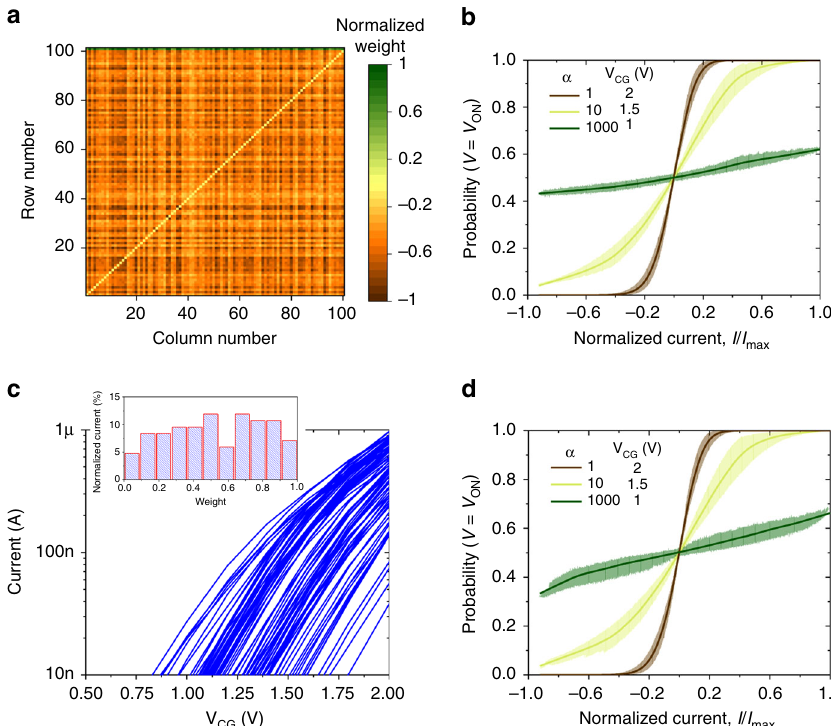
Fig. 4 Non-idealities in fl ash-memory-based stochastic dot-product circuits. a The considered distribution of neural network weights, normalized separately to its maximum value for positive (array) and negative (bias) weights. The bias weights are shown at the very top of the array. b Smearing of the stochastic neuron function due to input-dependent output-referred current noise in differential circuits for three computing temperatures. The thicker lines show the simulated values obtained by applying 10k randomly chosen inputs (neuron states) across all neurons, while solid lines show their averages. c Measured subthreshold slope I – V s for 100 memory cells. The inset shows the histogram of corresponding normalized synaptic weights, de fi ned as I cell ( V CG = 2.0V)/( I cell ) max , when using ( I cell ) max = 973 nA. d Simulated smearing of the stochastic neuron function due to the combined effect of subthreshold slope variations and differential summation in fl oating-gate memory implementation. The data were obtained similarly to that of panel ( b ), with only difference that subthreshold slopes for each device were randomly selected from the measured distribution and kept fi xed during simulations of different inputs NATURE COMMUNICATIONS| (2019) 10:5113